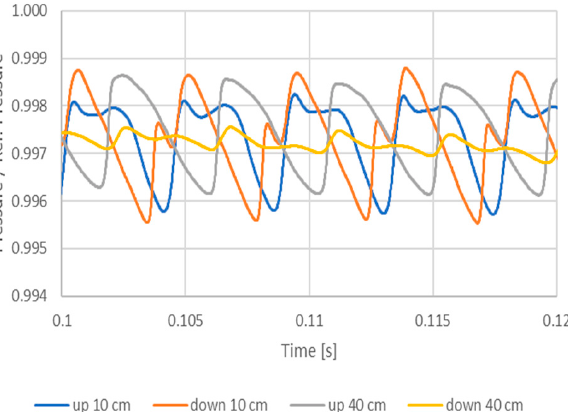
Figure 20. Pressure evolution in the upstream and downstream sections with different damper lengths equal to 10 cm and 40 cm.